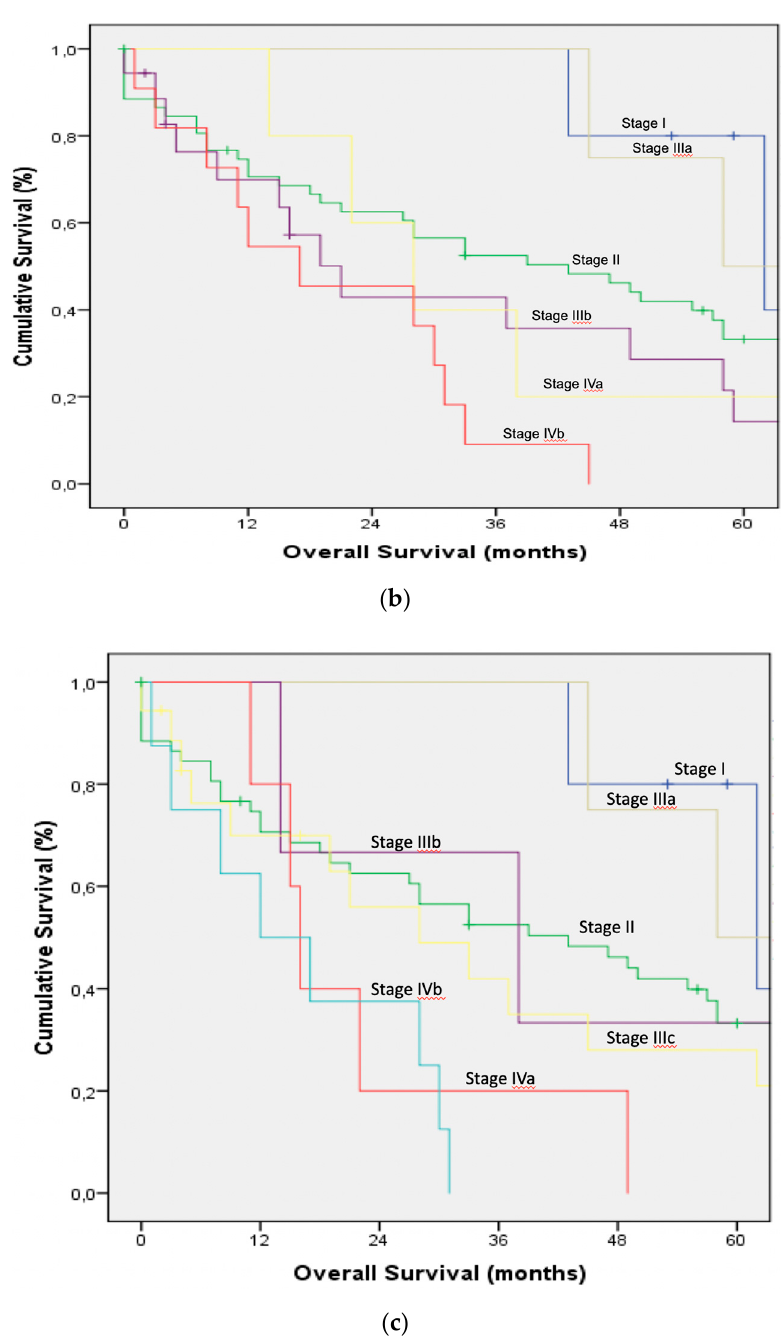
Figure 2. ( a ): Overall survival by the substages according to the 6th edition of the American Joint Committee on Cancer staging system. ( b ): Overall survival by the substages according to the 7th edition of the American Joint Committee on Cancer staging system. ( c ). Overall survival by the substages according to the 8th edition of the American Joint Committee on Cancer staging system.